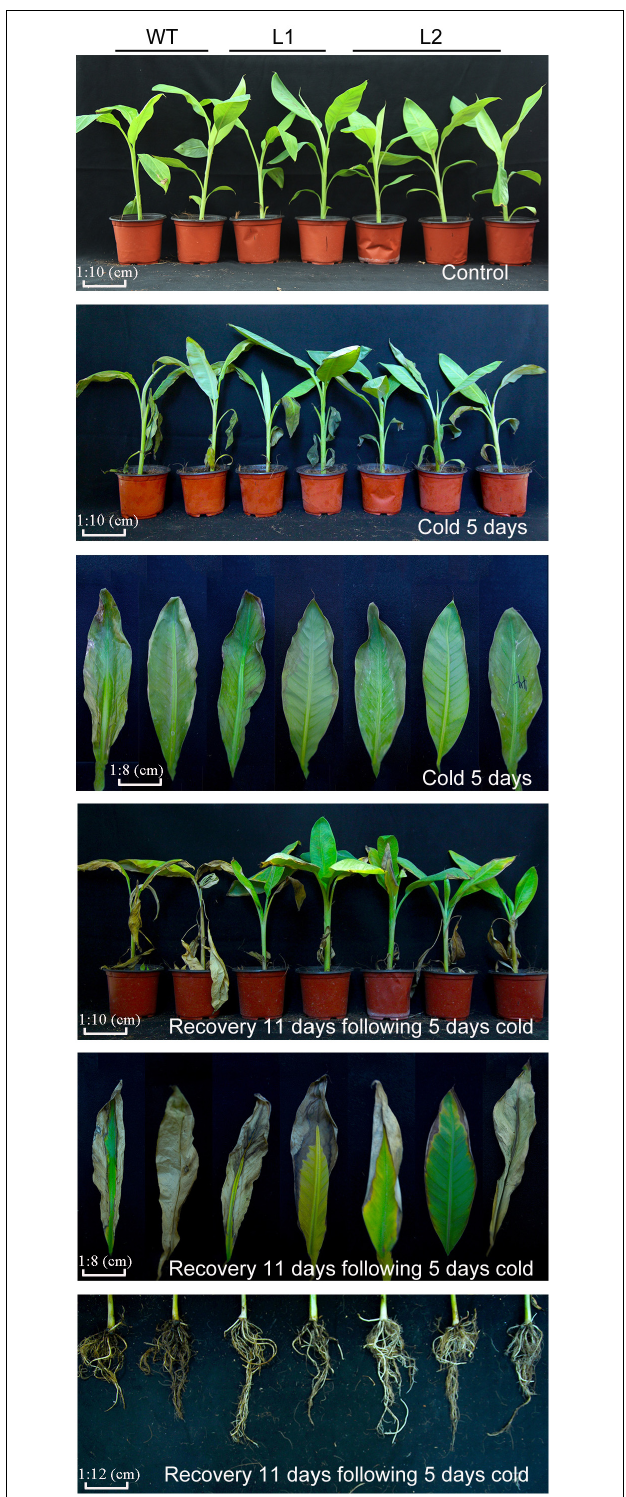
FIGURE 7 | Comparison of phenotypic differences between wild-type (WT) and transgenic lines under normal, cold, and recovery conditions. Banana seedlings (100-day-old) were subjected to cold treatment (8 ◦ C) for 5 days and recovery for 11 days after 5-day cold treatment. Then the photos were